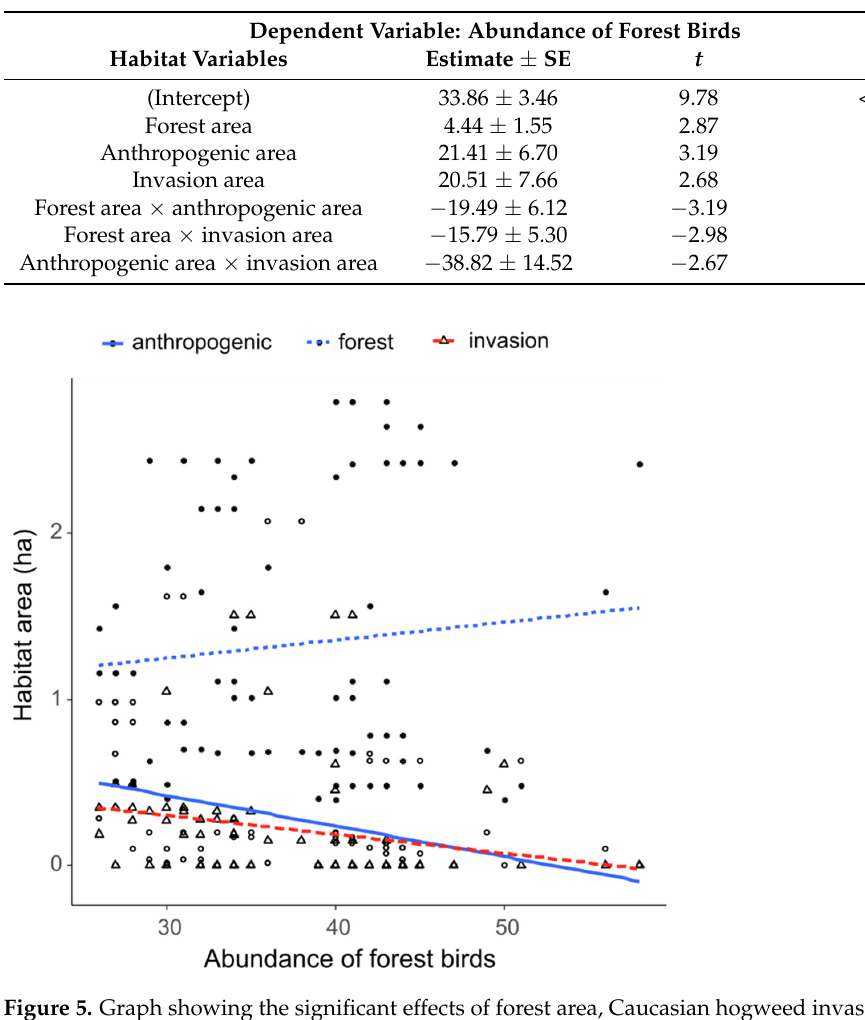
Table 1. Results of the LMM model with the forest bird abundance on each study site as a dependent variable, where “site ID” and “year” were the random effects, while areas of habitat variables on sites were the continuous predictors (number of observation sets across all surveys: N = 190, number of sites: N = 38).